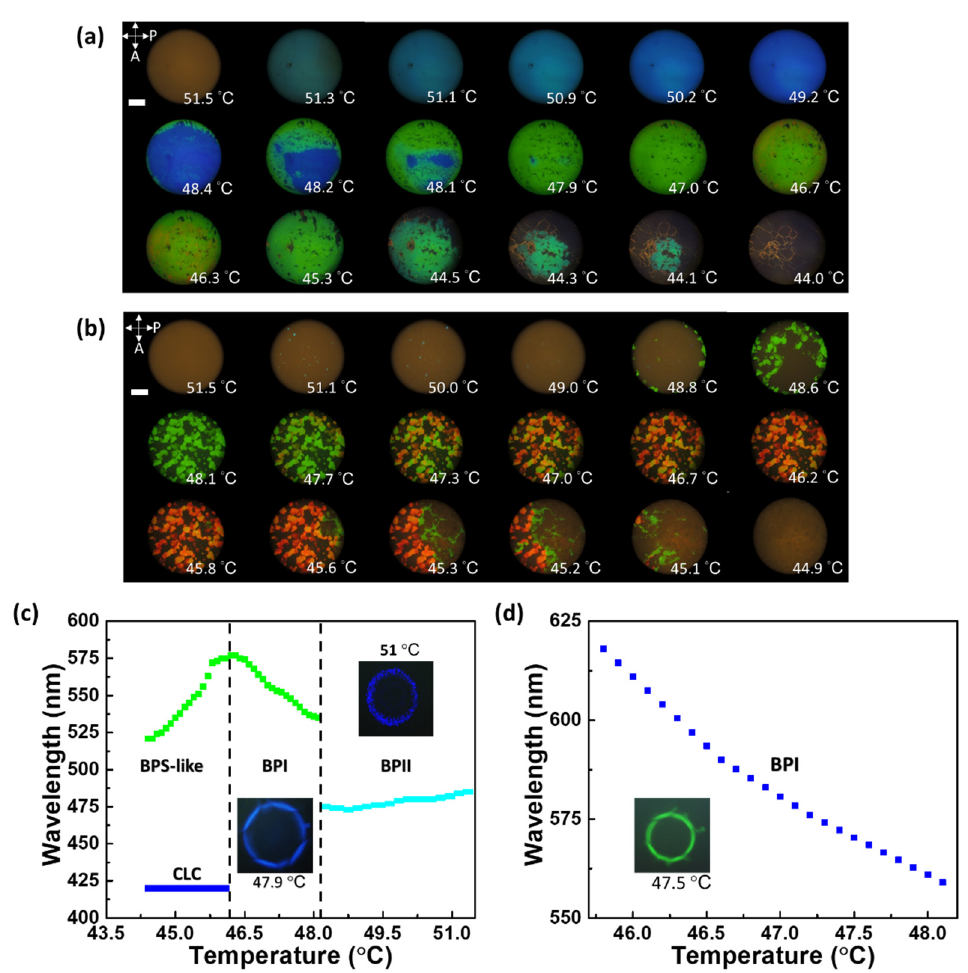
Figure 1. Reflective-type polarizing optical microscopic (R-POM) images of the chiral-azobenzene-doped blue phase liquid crystals (CA-BPLC) samples ( a ) with and ( b ) without surface alignment during cooling. The length of the scale bar is 100 µ m. Variation in the peak wavelength of the reflection of the CA-BPLC samples ( c ) with and ( d ) without surface alignment. The three insets in ( c , d ) are the Kossel diagrams for the aligned sample measured at 51 ◦ C and 47.9 ◦ C and the nonaligned sample measured at 47.5 ◦ C, respectively.